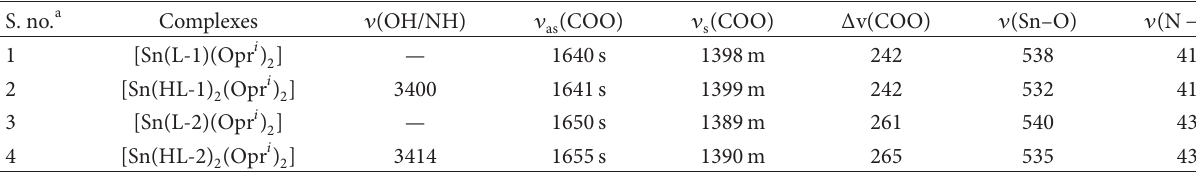
a Numbers as indicated in Table 2; s: strong; m: